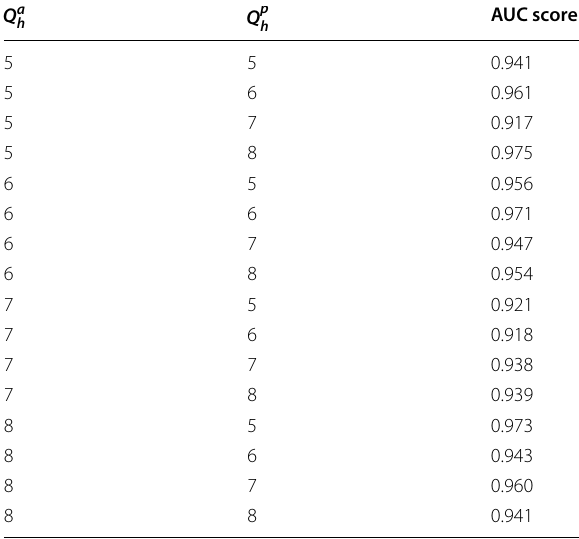
Table 11 AUC values of HAV (or T 25 to 64 using leave-one-out cross validation